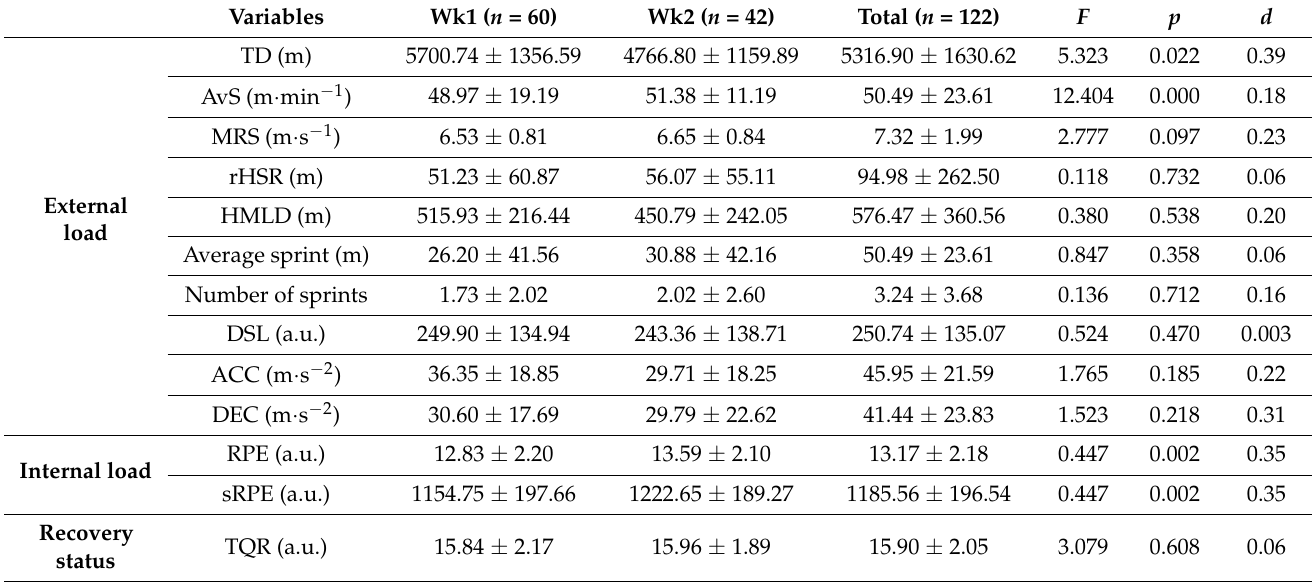
Table 3. Mean training load and recovery status per session for each week examined.